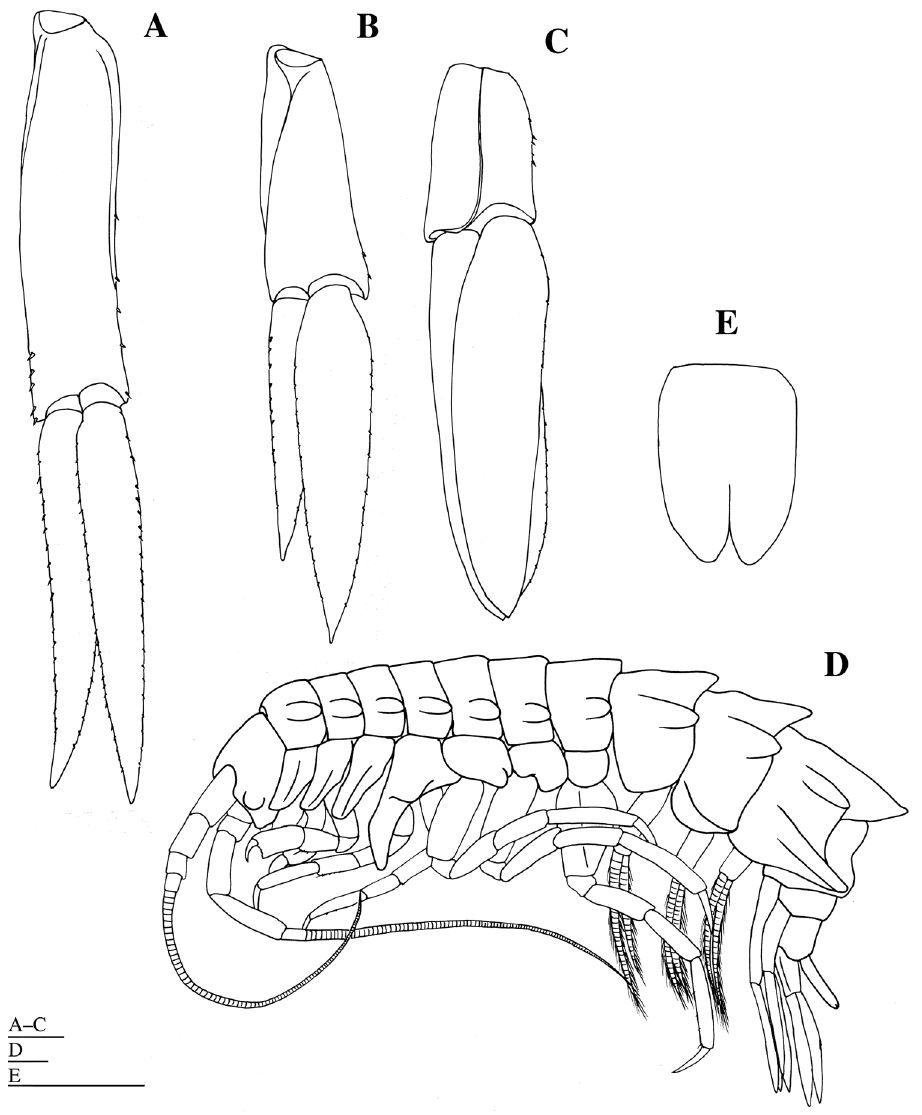
Figure 9. Epimeria abyssalis sp. n., A–C holotype female, D, E paratype female (KMNH IvR 500907): A left uropod 1, dorsal B left uropod 2, dorsal C left uropod 3, dorsal D habitus, lateral E telson, dorsal. Scale bars: 1